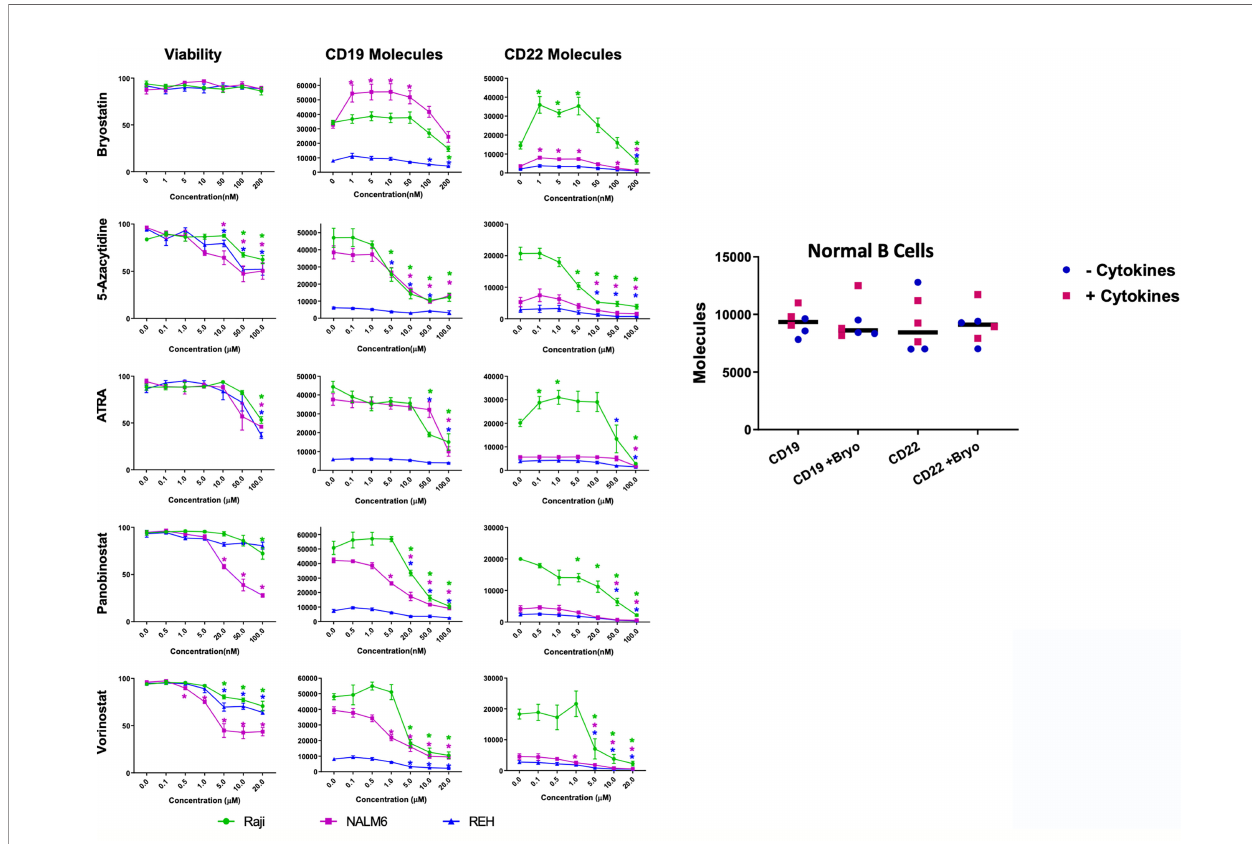
FIGURE 1 | Viability and Surface Expression of CD19 and CD22 in treated B-cell leukemia cell lines and normal B cells. Left panel: Epigenetic modi fi ers/ differentiation agents (Bryostatin, 5-Azacytidine, ATRA, Panobinostat or Vorinostat) were added at increasing concentrations (x-axis, as indicated) to the culture media of B cell lines (Raji-green circle, NALM6-magenta square, REH-blue triangle) for 48 hours (or 24 h for bryostatin). Following drug exposure, cell viability was calculated and plotted (column 1). Each agent adversely affected viability as concentration increased, except for bryostatin. Surface expression of CD19 (column 2) and CD22 (column 3) in leukemia cell lines was quali fi ed by fl ow cytometry using Quanti-Brite PE beads. Average of triplicate wells is shown, values differing from untreated controls are indicated, * indicates p<0.05. Right panel: Expanded peripheral blood B cells from three donors, cultured on CD40L expressing feeder cells in media supplemented with (squares) or without (circles) B cell growth factors (IL-2, IL-4, IL-21, BAFF, see Materials and Methods ), were tested for changes in cell surface expression induced by bryostatin. The number of CD19 and CD22 molecules differed between donors to a degree, but was not signi fi cantly impacted by bryostatin, paired t-test p>0.05, grand median, solid bar, shown for